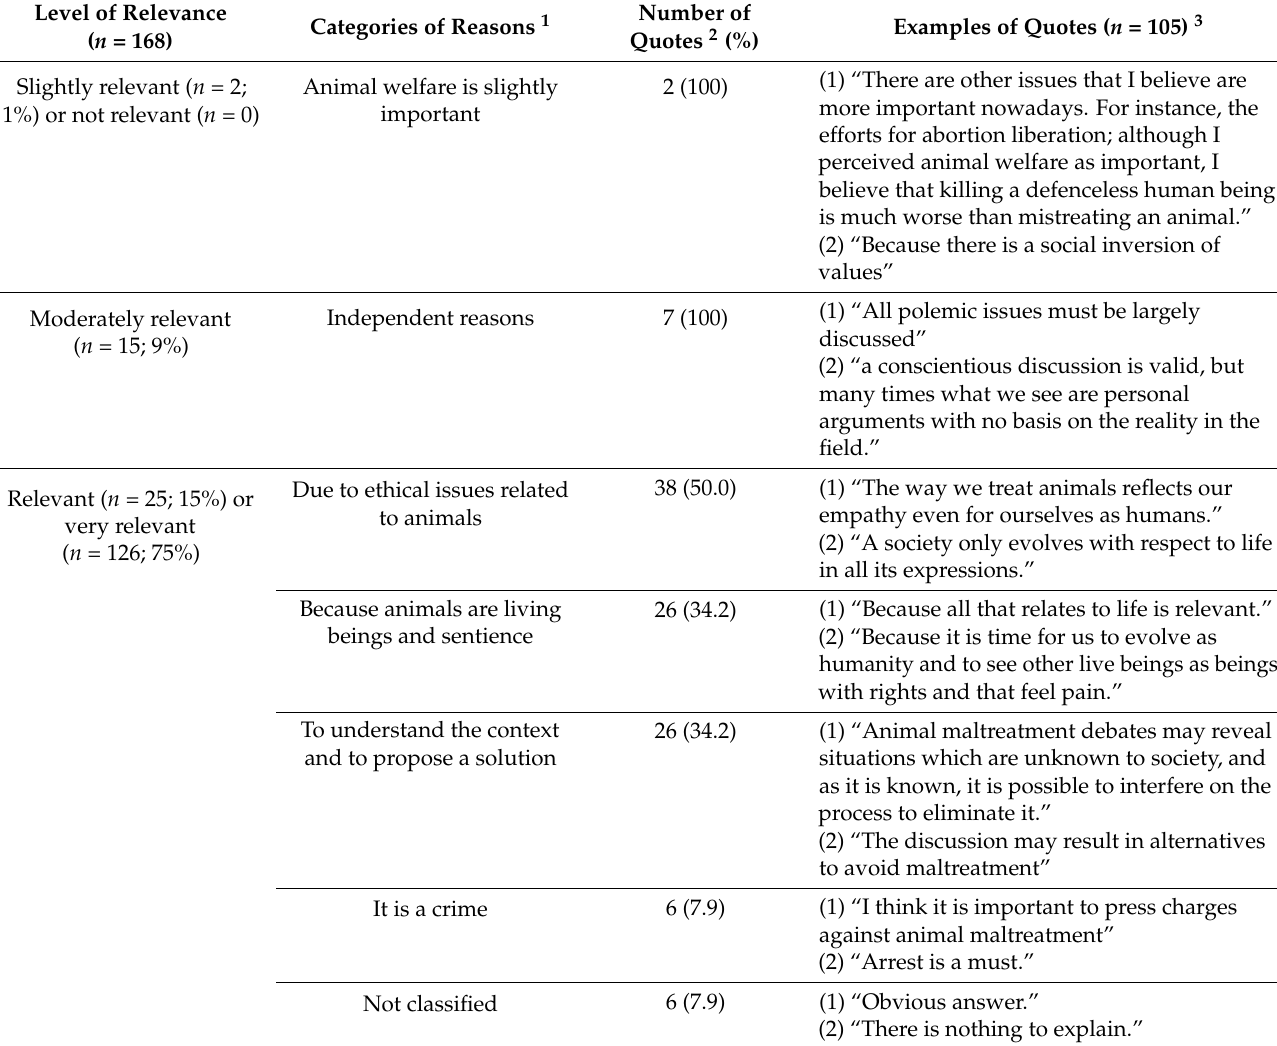
Table 5. The level of relevance on a five-point scale, from 1 (not relevant) to 5 (very relevant), regarding animal maltreatment debates and reasons given by citizens from Porto Alegre, South Brazil, from September 2017 to December